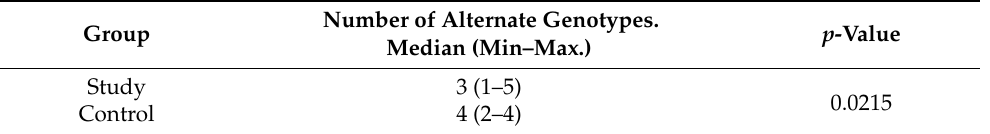
Table 7. Comparison of the number of genotypes containing alternative allele variants in the studied groups of patients.